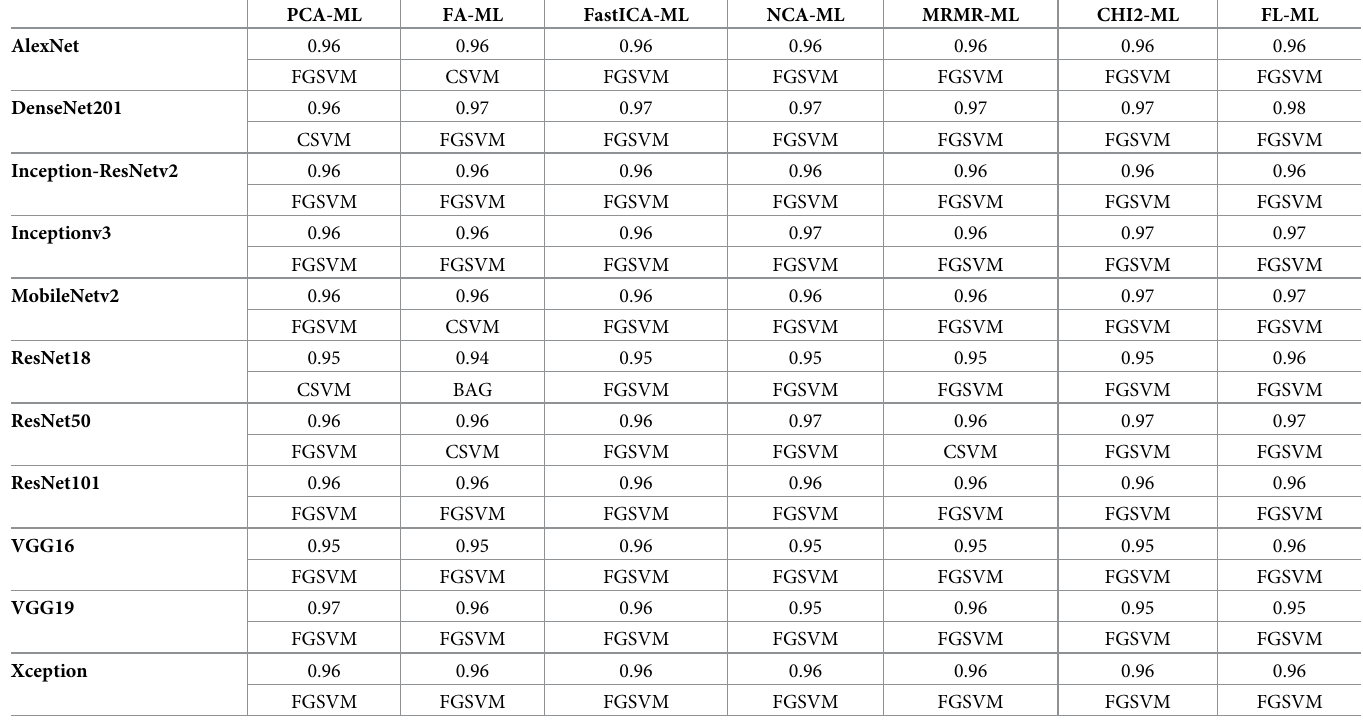
Table 9. The best ML learner for each combination method and its average classification performance (using Recall